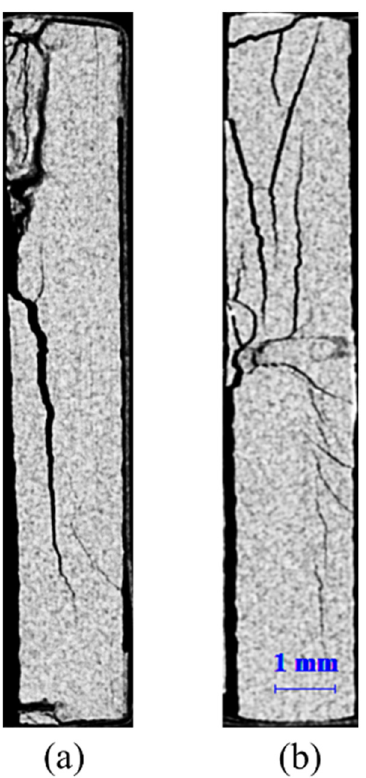
Figure 9: Microscopic morphology through the third direction of ( a ) composite and ( b ) Z - pin composite under three - point failure after moisture coupled with fl exural load for 7